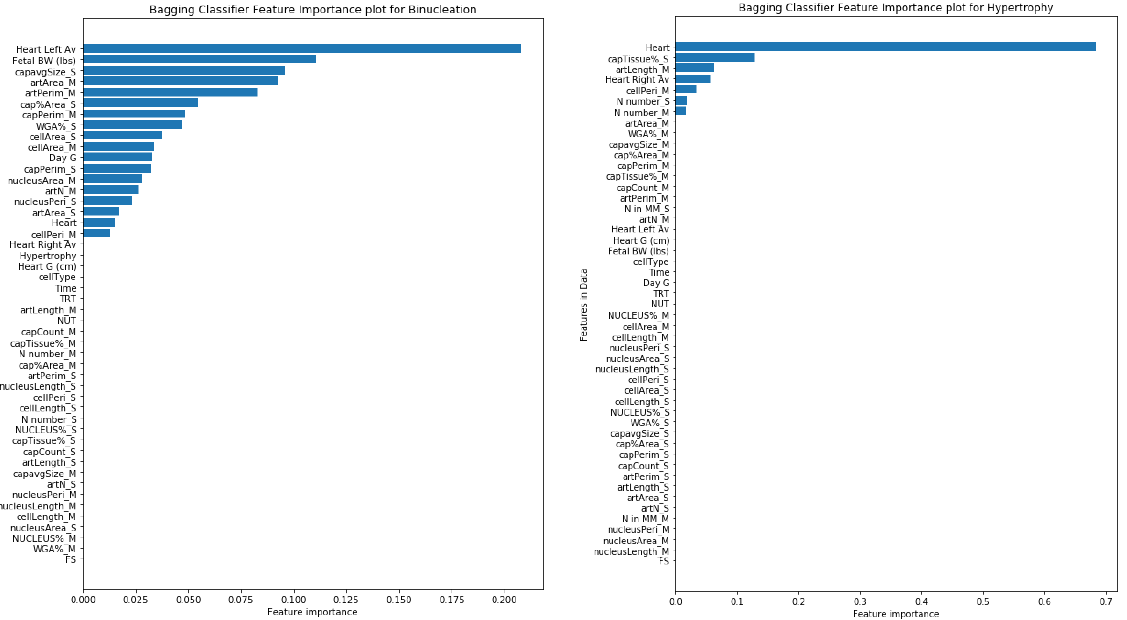
Figure 5. Importance of each feature during the prediction of target variables Binucleation & Hypertrophy with Bagging